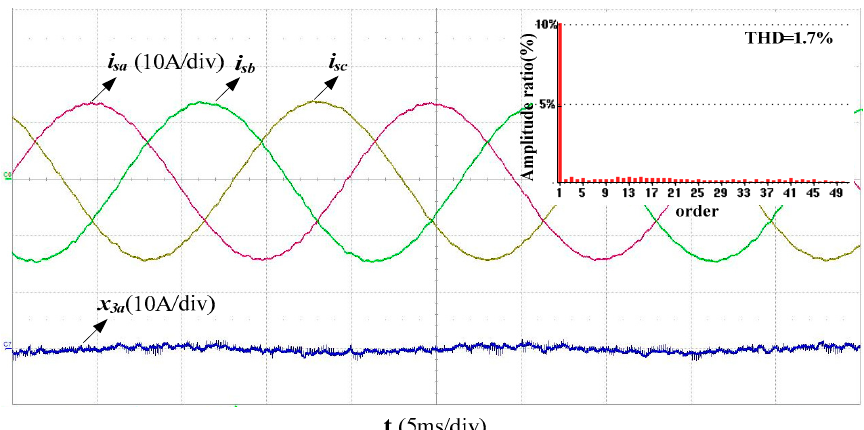
Figure 15. Experimental waveform of the grid current and harmonic error with RCSMC.